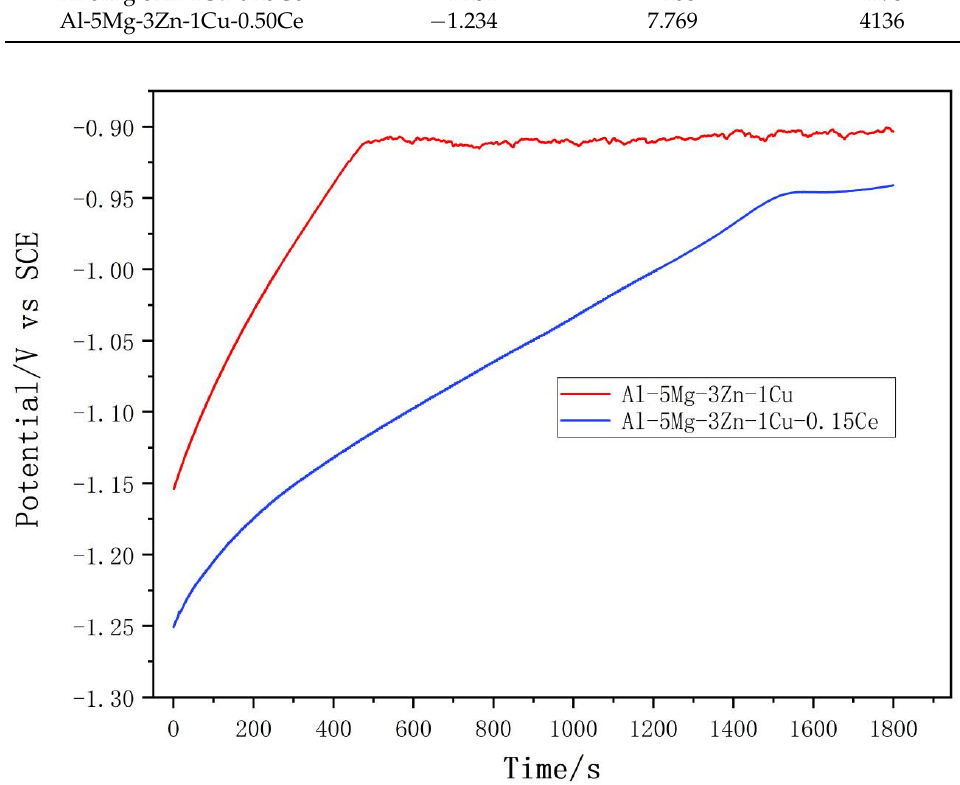
Figure 6. Open circuit potential curve for Al-5Mg-3Zn-1Cu alloy without Ce and with 0.15%